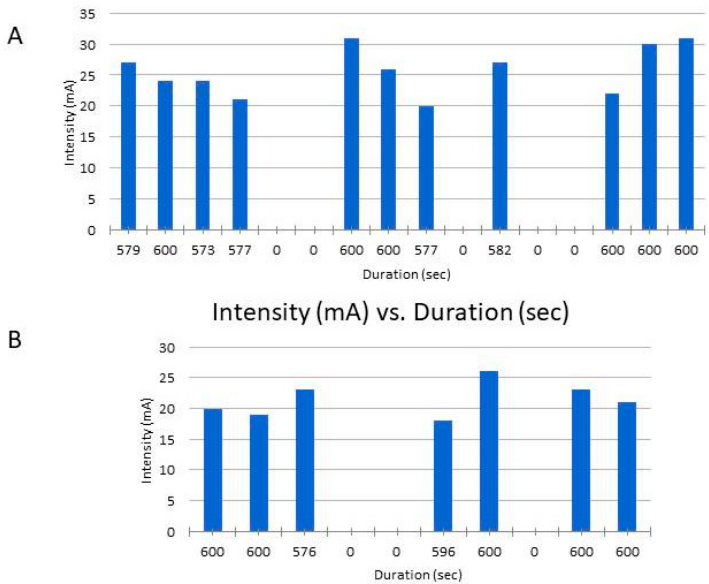
Figure 2. Stimulation intensity and duration during the first ( A ) and second ( B ) stimulation protocol.